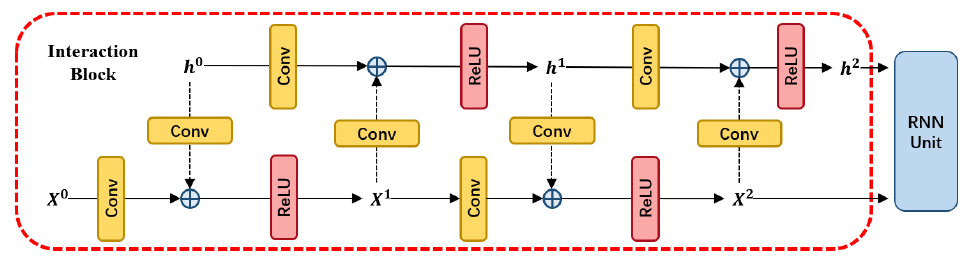
Figure 2. The interaction block. It interacts with the representation between the hidden state h and the input x .